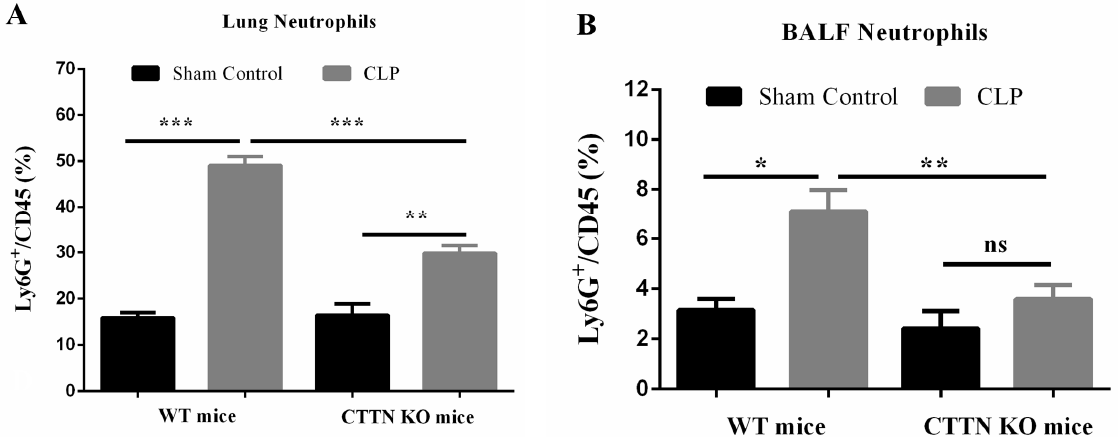
Figure 4. Septic cortactin-deficient mice show reduced neutrophil infiltration into the lung. The percentage of CD45+ LY6G+ neutrophils in lung tissue ( A ) and in BALF ( B ) was determined by flow cytometry 24 h after CLP-sepsis or sham control. Data are represented as mean ± SEM of at least 6 animals per group. * p < 0.05, ** p < 0.01, *** p < 0.001. BALF: Bronchoalveolar lavage fluid. 3.5. Oxidative Stress Is Ameliorated in the Lungs of Cortactin-Deficient Mice during Sepsis